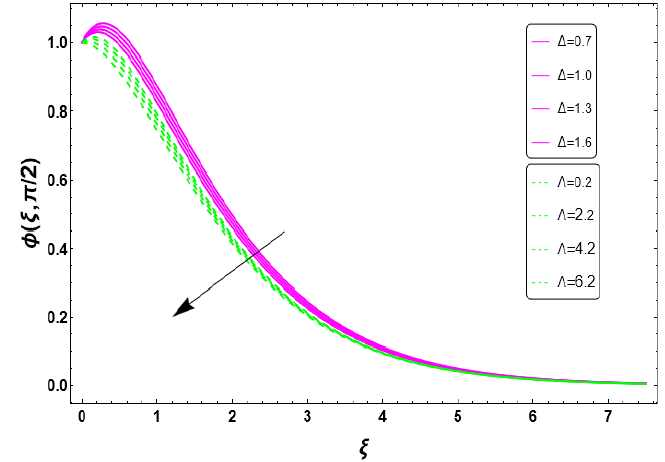
Δ Λ φ Δ Λ for and . φ for and .